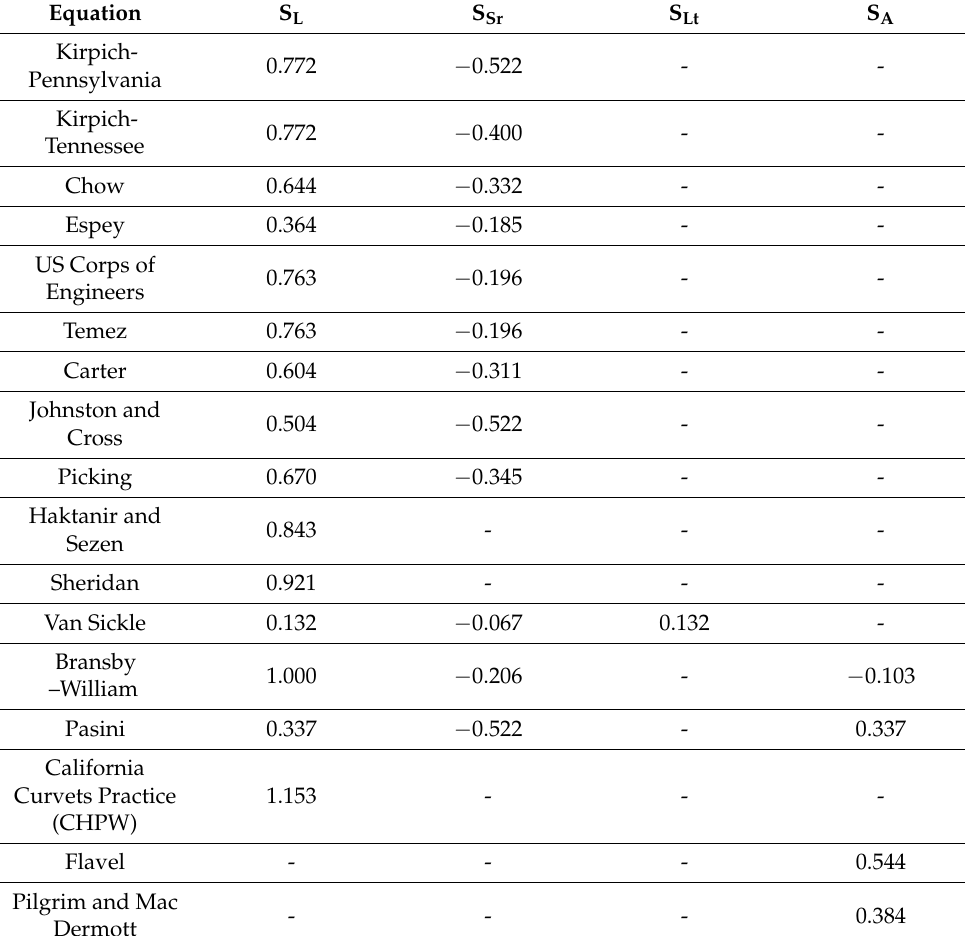
Table 7. Sensitivity coefficients of the methods based on L , L t , S r and A (category I).